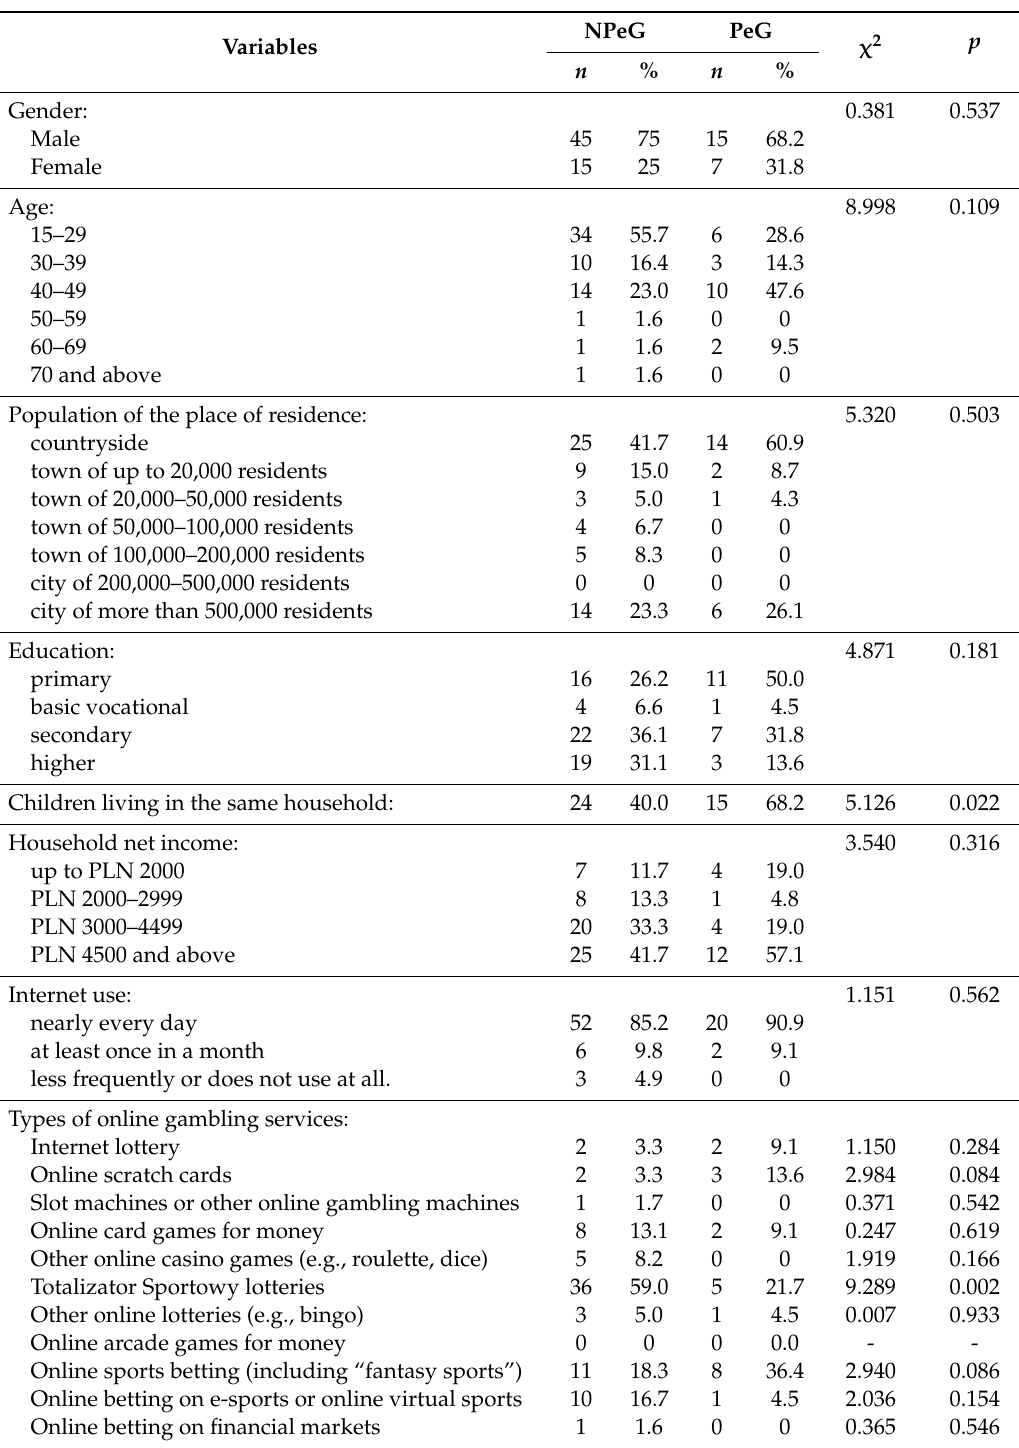
Table 4. Comparison of sociodemographic variables between non-problem online gamblers (NPeG, n = 61) and problem online gamblers (PeG, n =